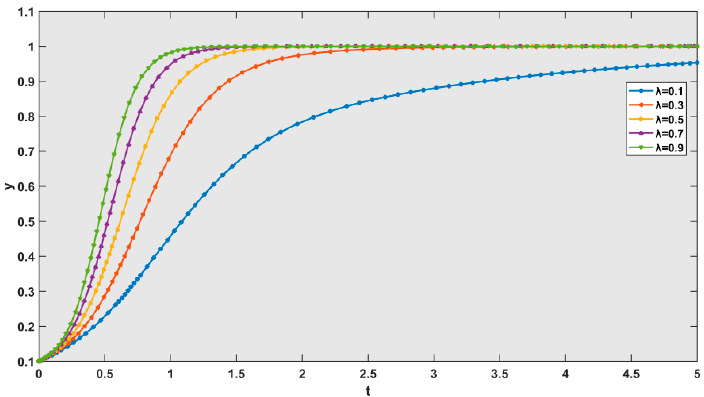
Figure 6. The influence of the change of λ on the innovation-supplying enterprises’ evolution trajectory.